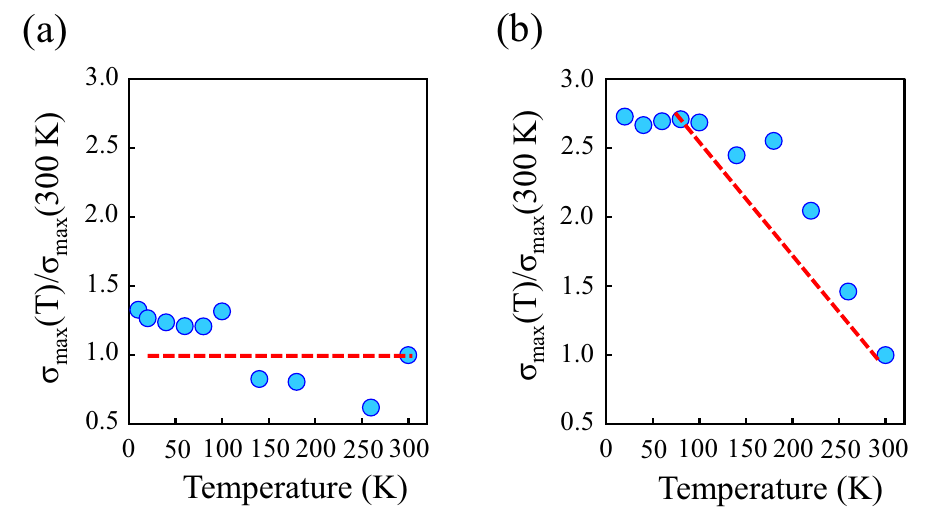
Figure 8. Temperature dependence of the σ max measured from ( a ) the pristine monolayer GNR-FET and ( b ) the grown multilayer (6L) GNR-FET, respectively.